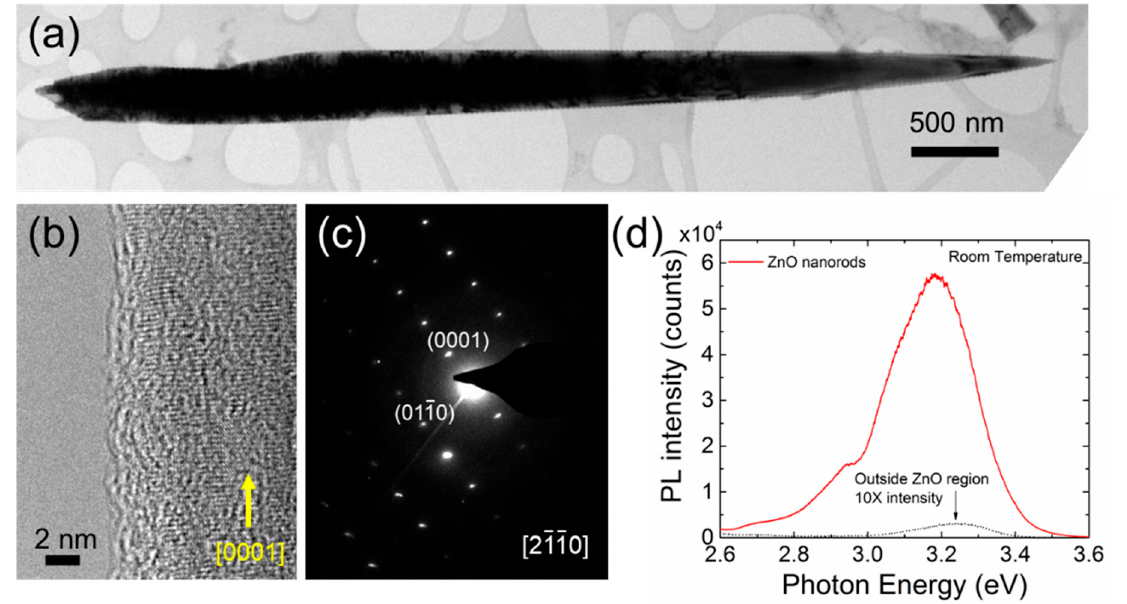
Figure 2. ( a ) Low magnification, ( b ) high-resolution TEM images, and ( c ) electron diffraction pattern of an individual ZnO NW grown on CVD-graphene via hydrothermal method. ( d ) Room temperature µ–PL spectra of ZnO NWs and SiO 2 outside graphene.